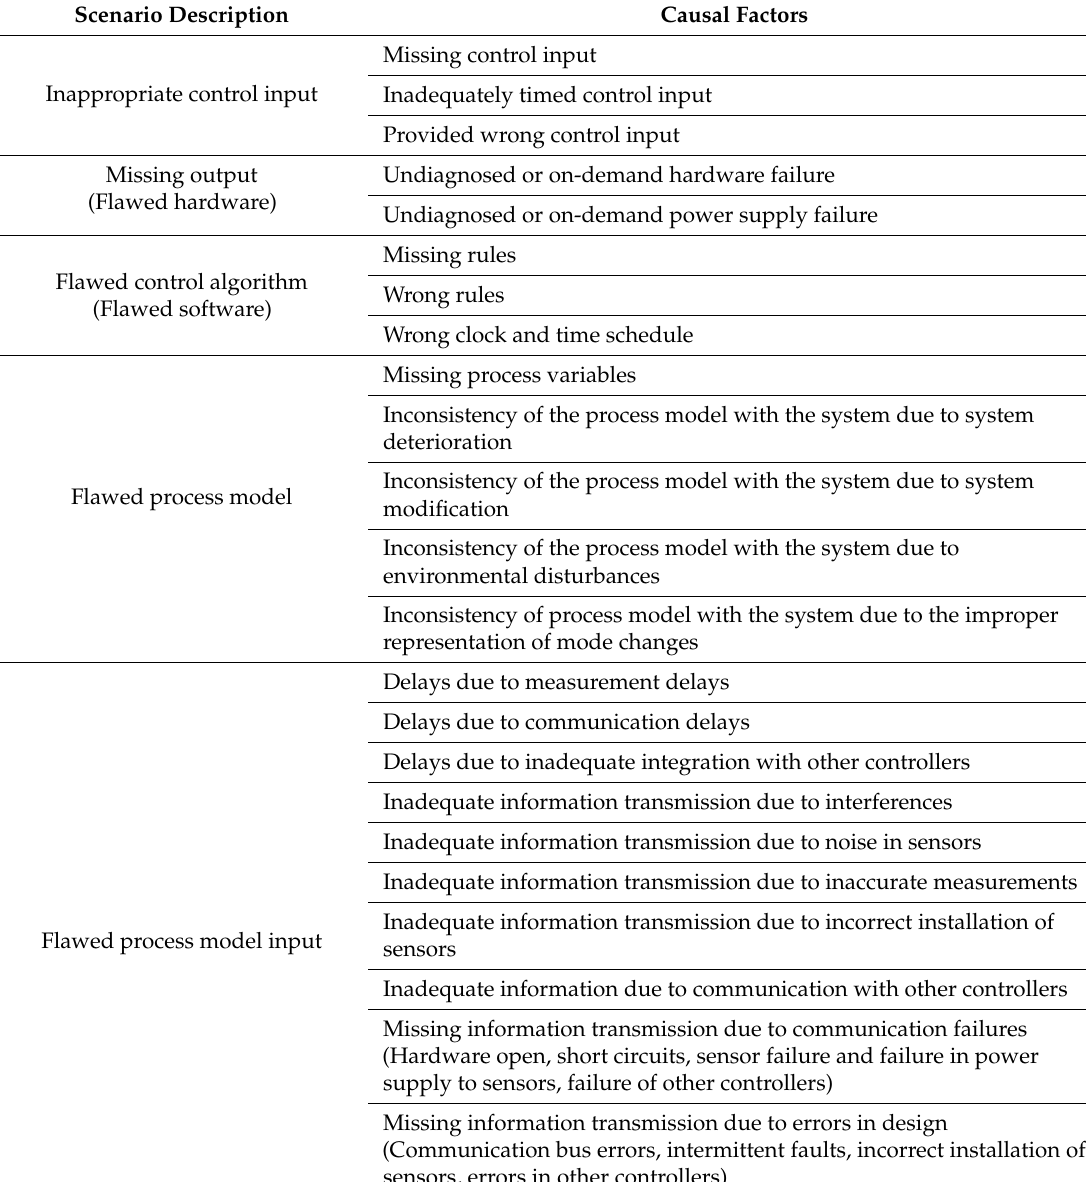
Table A1. Causal factors for provided